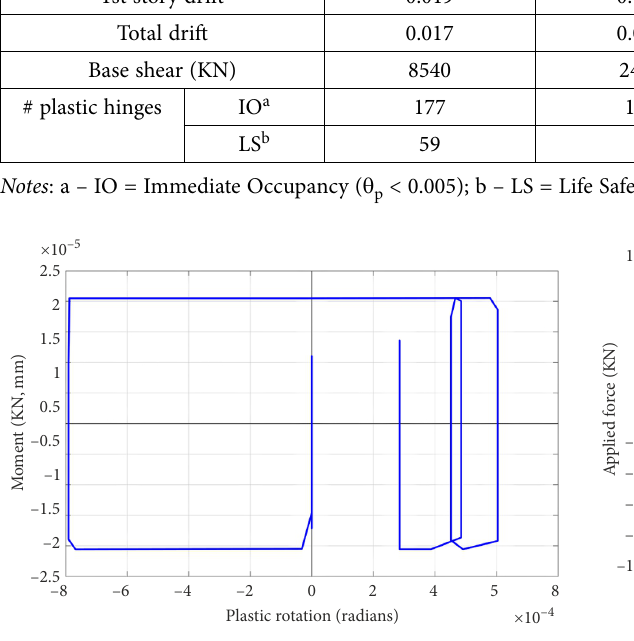
Fig. 3. Plastic hinge behaviour of a columns on the ground floor in the elastoplastic domain